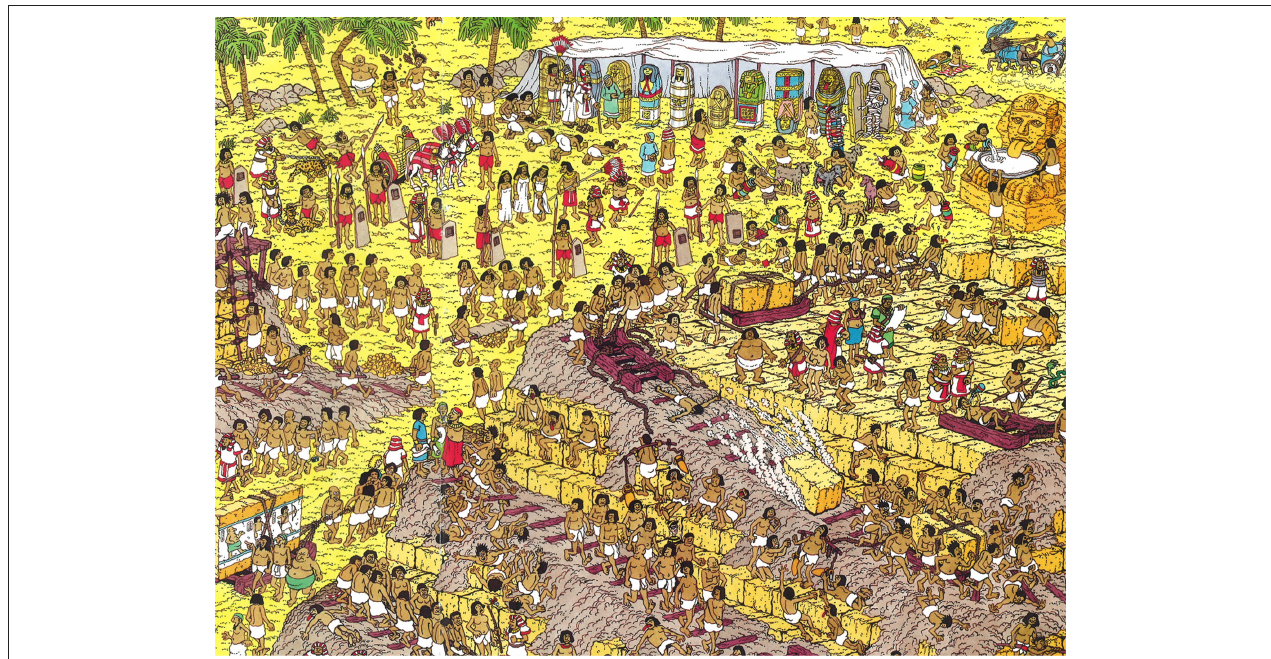
FIGURE 1 | Example stimulus used in the production and comprehension studies. In production, participants had to identify a designated target. In comprehension, the four referring expressions for this trial were (i) “at the upper right, the sphinx” [landmark only]; (ii) “at the upper right, the man holding the red vase with a stripe” [target only]; (iii) “at the upper right, the man holding the red vase with a stripe to the left of the sphinx” [landmark follows target]; (iv) “at the upper right, to the left of the sphinx, the man holding the red vase with a stripe on it” [landmark precedes